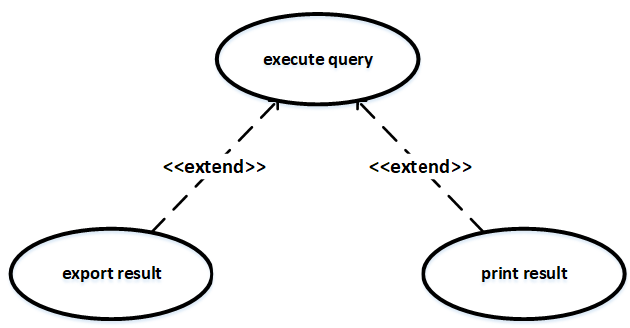
Figure 8. The extend relationship between use cases.